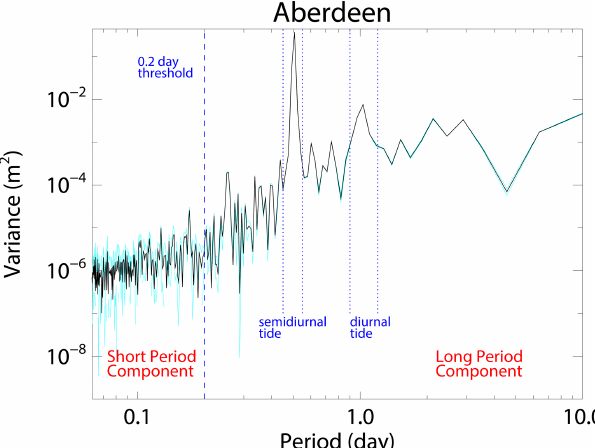
Figure 5. Sample spectrum of water level for Aberdeen across the 16d period 8–23 January 2007. The 0.2d threshold separating the short period and long period components of the time series recon- structions is shown, as well as the thresholds defining the diurnal and semidiurnal components that were used to de-tide the time se- ries. The uncertainty in the spectrum (light blue line) was calculated as the standard deviation of three spectra derived from re-sampling the time series at every third